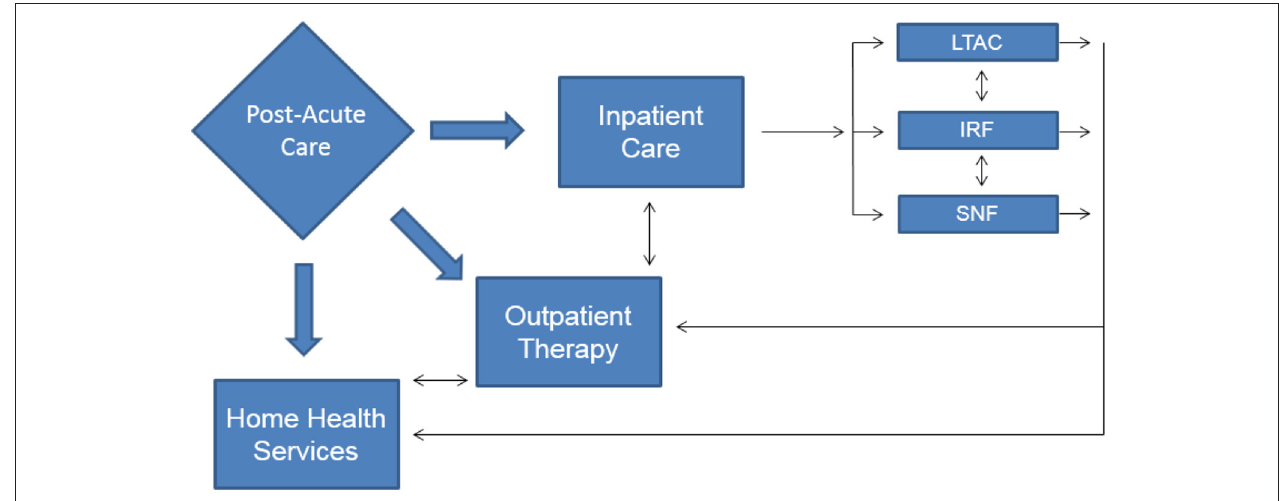
FIGURE 1 | Post-acute care rehabilitation